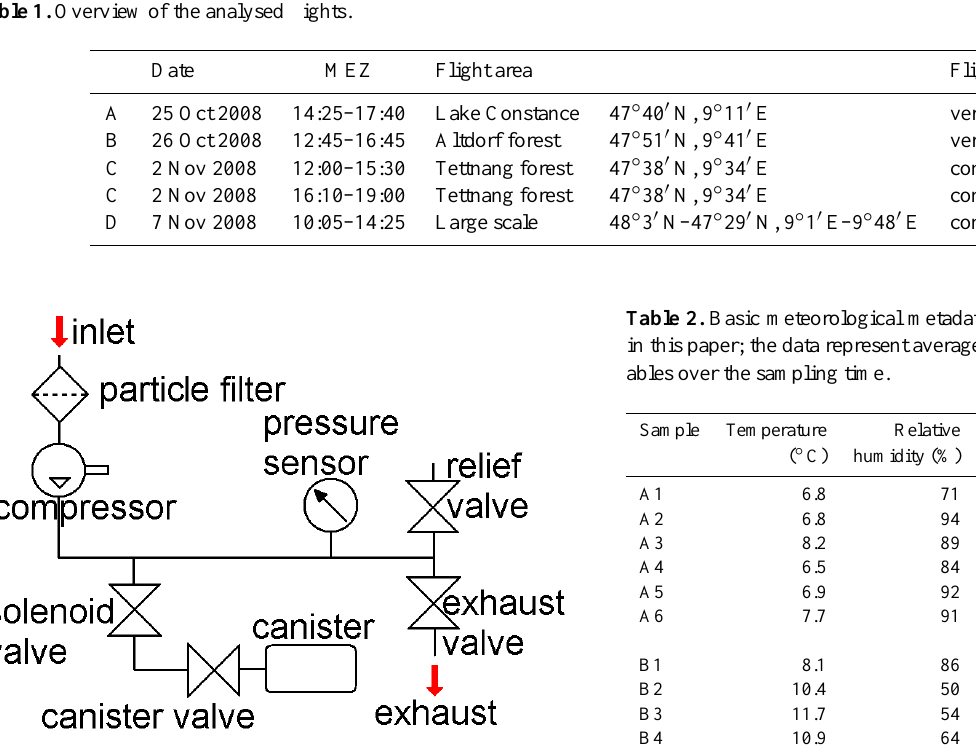
Fig. 3. Gas flow system of the whole air sampler ZEBIS; one canister is shown as an example, the total number of canisters is eight.